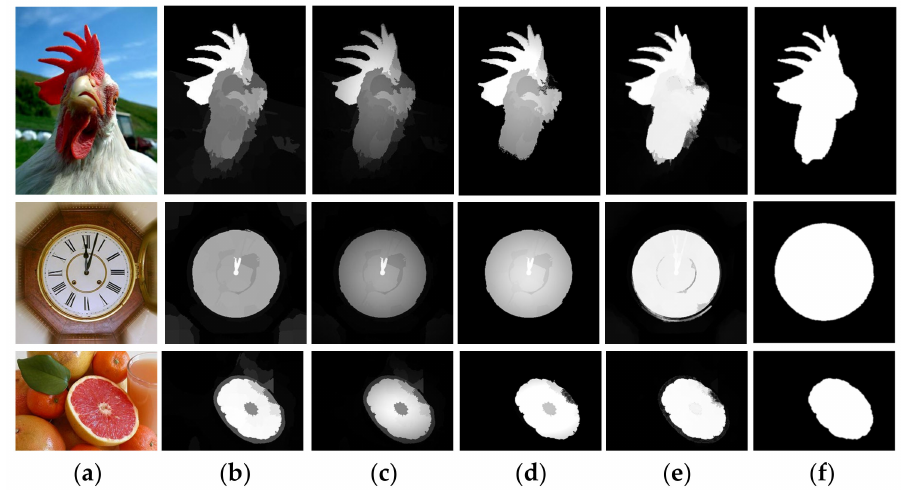
Figure 8. Main phases of pixel-wise refinement process. ( a ) Original image. ( b ) S unite saliency maps. ( c ) S init saliency maps. ( d ) Saliency maps after single-layer updating process. ( e ) Saliency maps after multi-layer integration process. ( f ) Ground